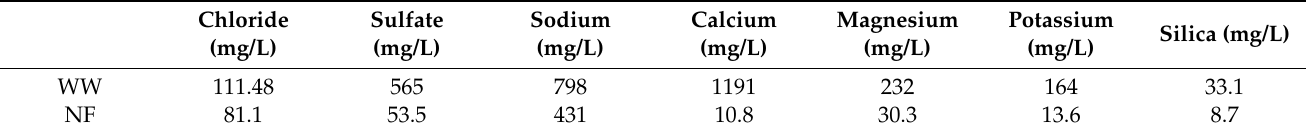
Table 5. Ion concentrations of raw feed water (WW) and NF-pretreated